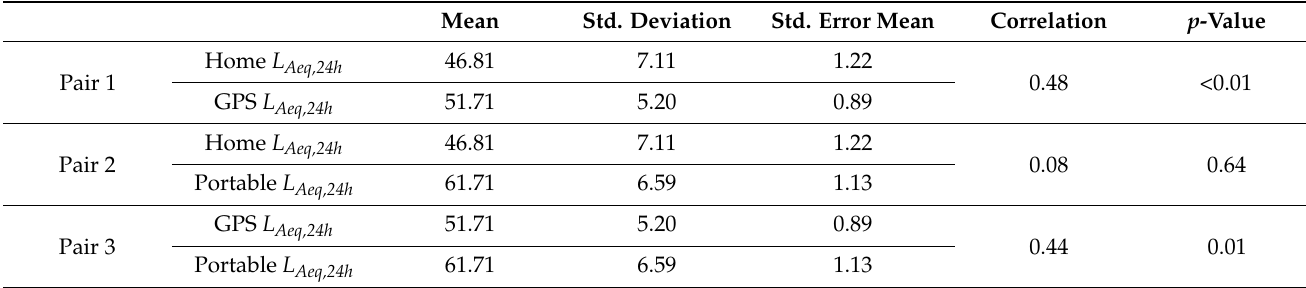
Table 5. Descriptive statistics and correlation between the three measures of individual noise exposure.